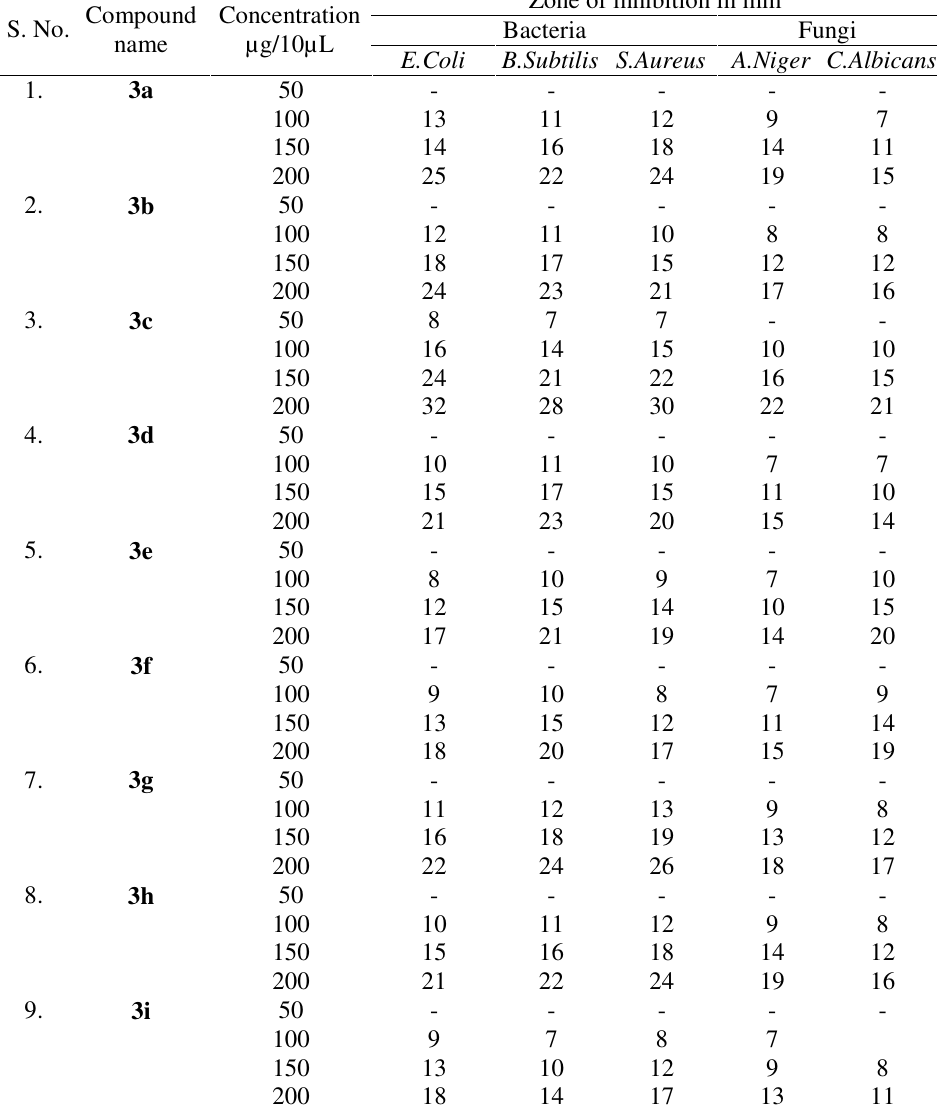
Table 2. Antimicrobial and antifungal activity of compounds 3 (a-i